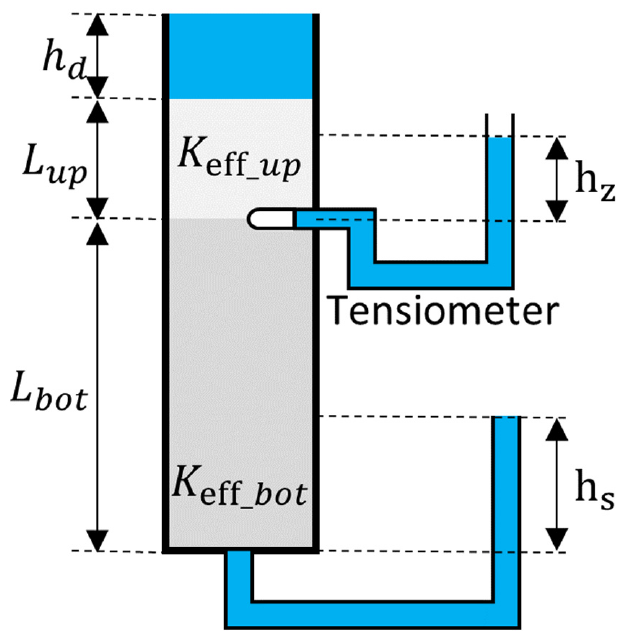
Figure 1. The schematic diagram of the one-dimensional vertical infiltration model. h d (m) is the constant surface water depth, h z (m) is the pore water pressure head at the location of the tensiometer, and h s (m) is the pressure head at the outlet of the model. L up (m) and L bot (m) are lengths of the upper zone and the bottom zone in the lysimeter. K ef f _ up and K ef f _ bot are the effective hydraulic conductivity in the upper zone and the bottom zone in the lysimeter.